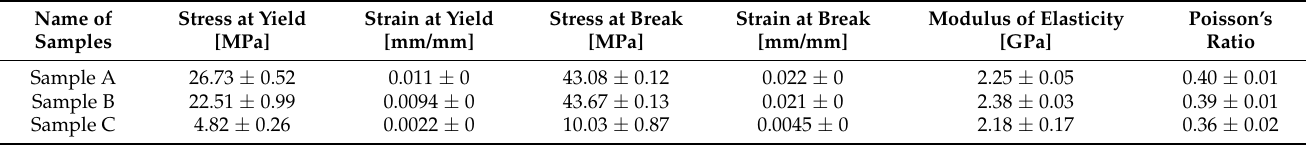
Figure 6. Example of the stress-strain curve of crystal poly-ether-ether-ketone specimen A1. Table 2. Results of the uniaxial tensile experiment on the amorphous-form